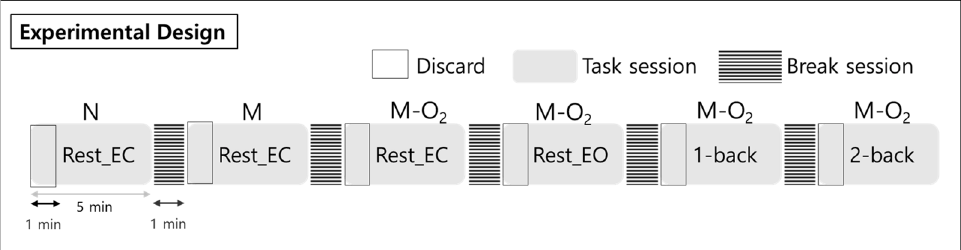
Figure 1. Experimental design for the rest states and n-back tasks, including nose and mouth breathing, and mouth breathing with O 2 supply. Subjects performed a total of 6 tasks, each a five-minute session, in a random order. There was a break for one minute between tasks, and the data from the first one minute was excluded from the analysis. Note: Rest_EC, resting state with closed eyes; Rest_EO, resting state with open eyes; N, nose breathing; M, mouth breathing; M-O 2 , mouth breathing with O 2 supply.